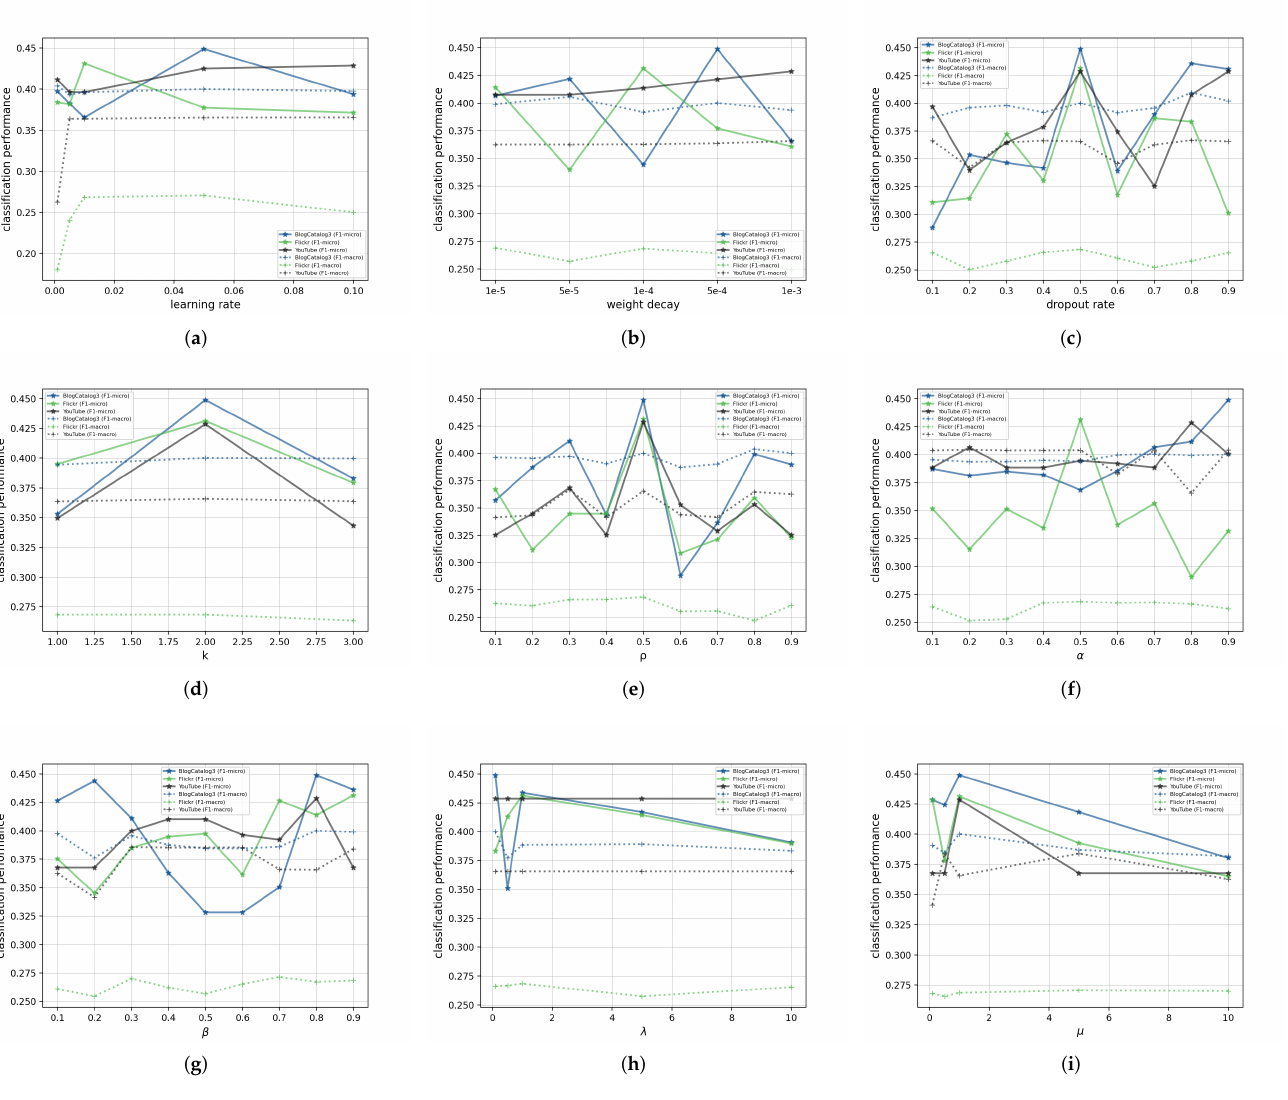
Figure 7. The effect of key parameters on the performance of SORAG F for each dataset: ( a ) learning rate; ( b ) weight decay; ( c ) dropout rate; ( d ) k; ( e ) ρ ; ( f ) α ; ( g ) β ; ( h ) λ ; ( i ) µ